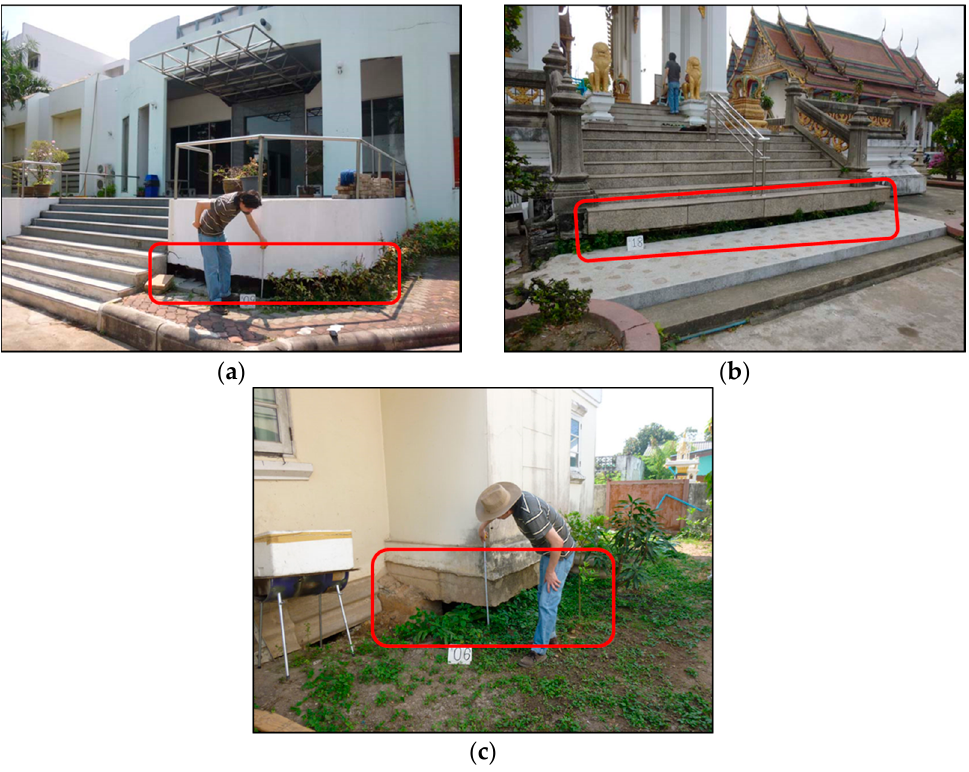
Figure 1. Differential settlement (DS) of buildings observed in Bangkok, Thailand: ( a ) a building at King Mongkut’s Institute of Technology Ladkrabang with a gap height of 240 mm; ( b ) an old temple with a gap height of 492 mm; and ( c ) a residential house with a gap height of 476 mm. The red rectangles denote the observed DS.